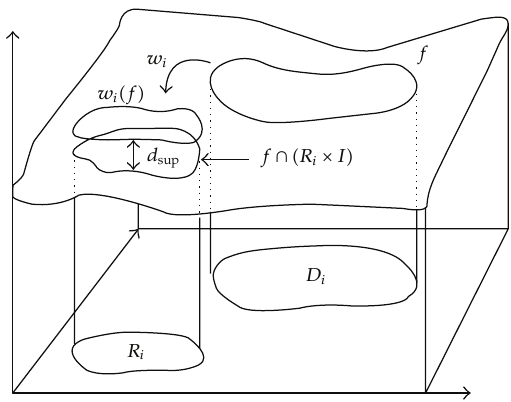
Figure 1: Domain and range